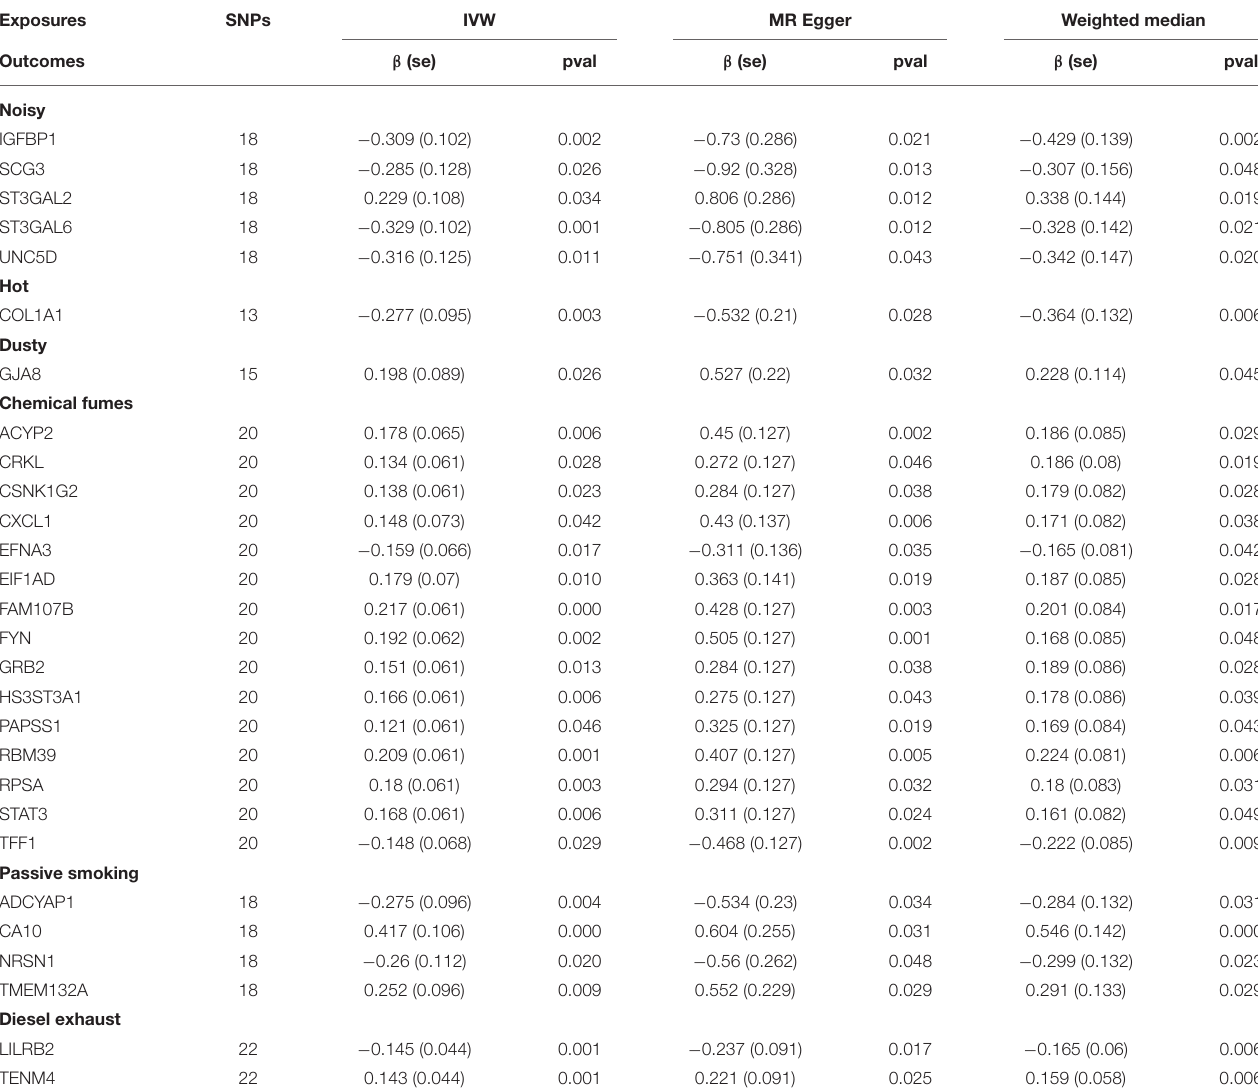
( Figure 3 ). CA10 and TMEM132, which were upregulated by passive smoking, are predicted risk factors for lung cancer and tinnitus, respectively ( Figure 3